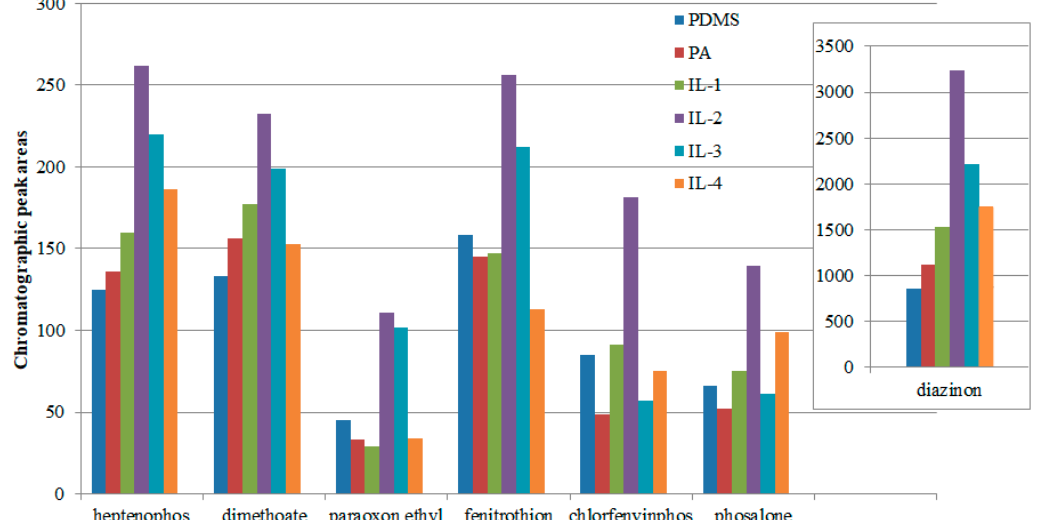
Figure 4. Comparison of the extraction abilities of the investigated insecticides for different ILs, and with reference PA and PDMS commercial fibers, under optimal conditions.